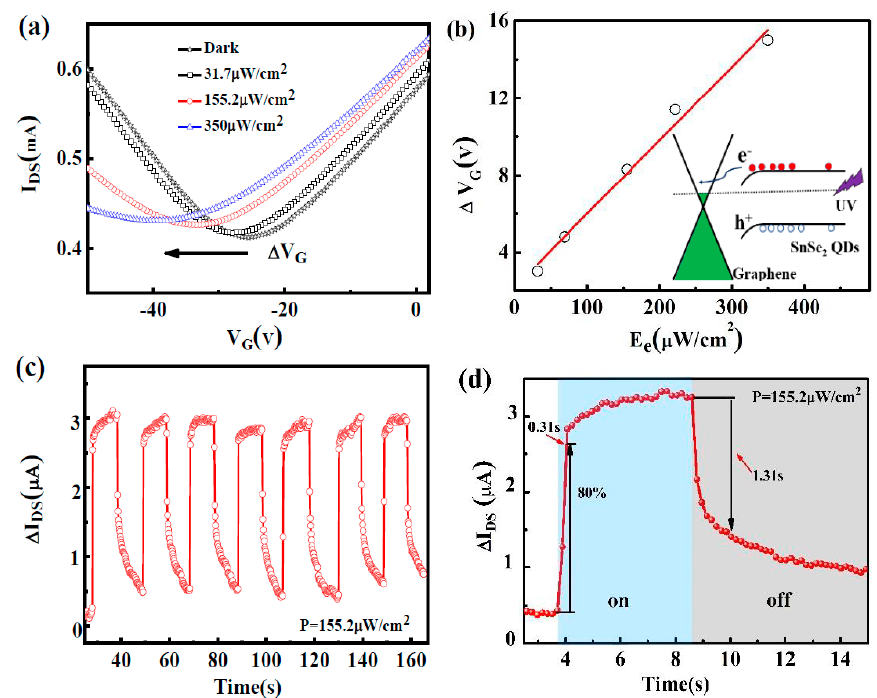
Figure 5. ( a ) Transfer characteristics of a graphene photodetector decorated with SnSe 2 quantum dots at different illumination densities (wavelength: 405 nm, V DS = 0.5 V); ( b ) horizontal shift of transfer curves as functions of illumination densities. The inset shows the charge transfer between SnSe 2 QDs and graphene; ( c ) current response to on/off light illumination for several cycles; ( d ) photocurrent response time of the device. (V DS = 0.05 V, illumination density: 155.2 µW/cm 2 ).